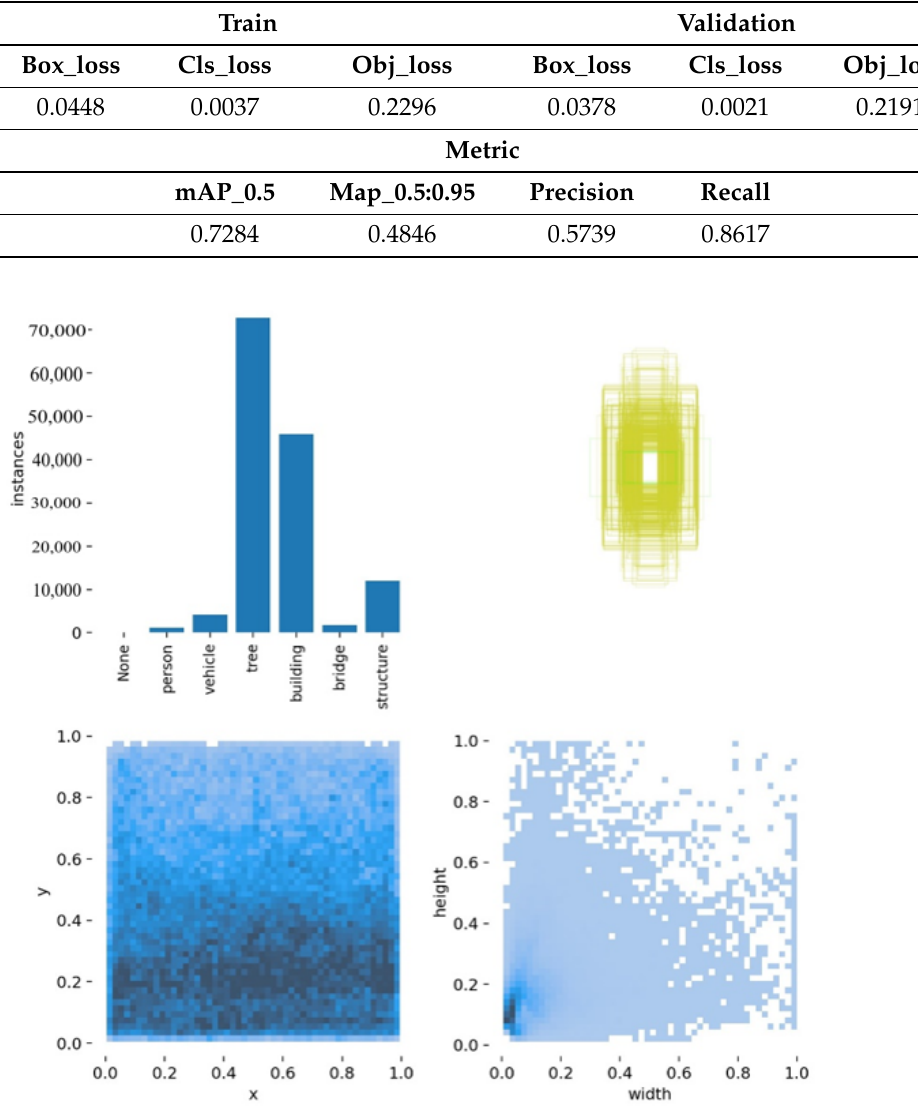
Figure 6. The result of objects’ distribution. The coordinates of the object are largely near the bottom of the image and are distributed over a small region, indicating that when flying at a high altitude, only a few objects need to be